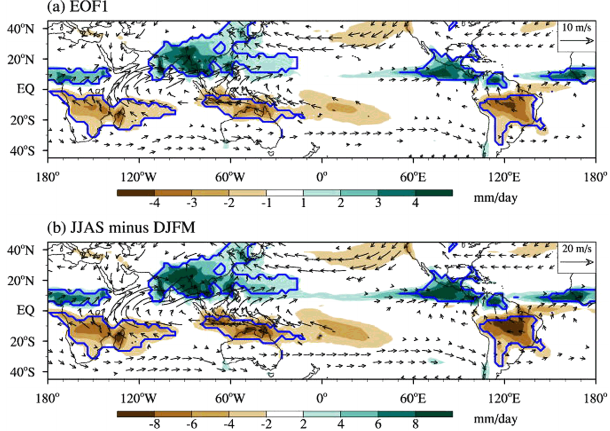
Figure 4. (a) The spatial pattern of the leading multi-variable EOF of precipitation rate (shading, unit mmday − 1 ) and winds (vectors in units of ms − 1 ) at 850hPa that correspond to a normalized prin- cipal component, and (b) the precipitation rate (mm day − 1 ) and 850hPa wind differences from June through September and Decem- ber through March (JJAS minus DJFM). Winds with wind speeds less than 1ms − 1 and 2ms − 1 are omitted in (a) and (b) , respec- tively. The monsoon precipitation domain is outlined by the blue